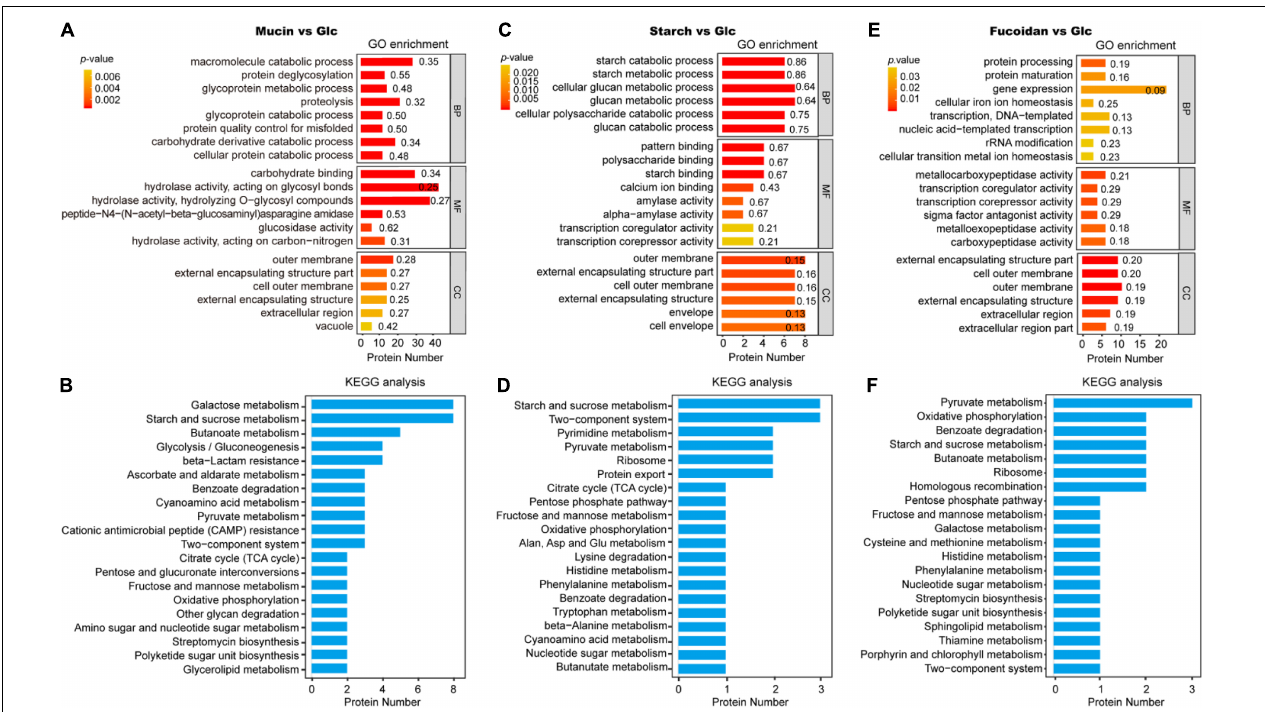
FIGURE 6 | Gene ontology and Kyoto Encyclopedia of Genes and Genomes analysis of differentially expressed FGPs in different comparisons. GO and KEGG analysis of differentially expressed FGPs in mucin vs. glucose (A,B) , starch vs. glucose (C,D) , fucoidan vs. glucose (E,F) . The p -values were obtained based on Fisher’s exact test. The smaller the p -value, and the higher the significance level of the corresponding functional category enrichment. Numbers beside the bars mean rich factors, indicating the ratio of the number of differentially expressed proteins annotated to the function to the number of all proteins identified to the